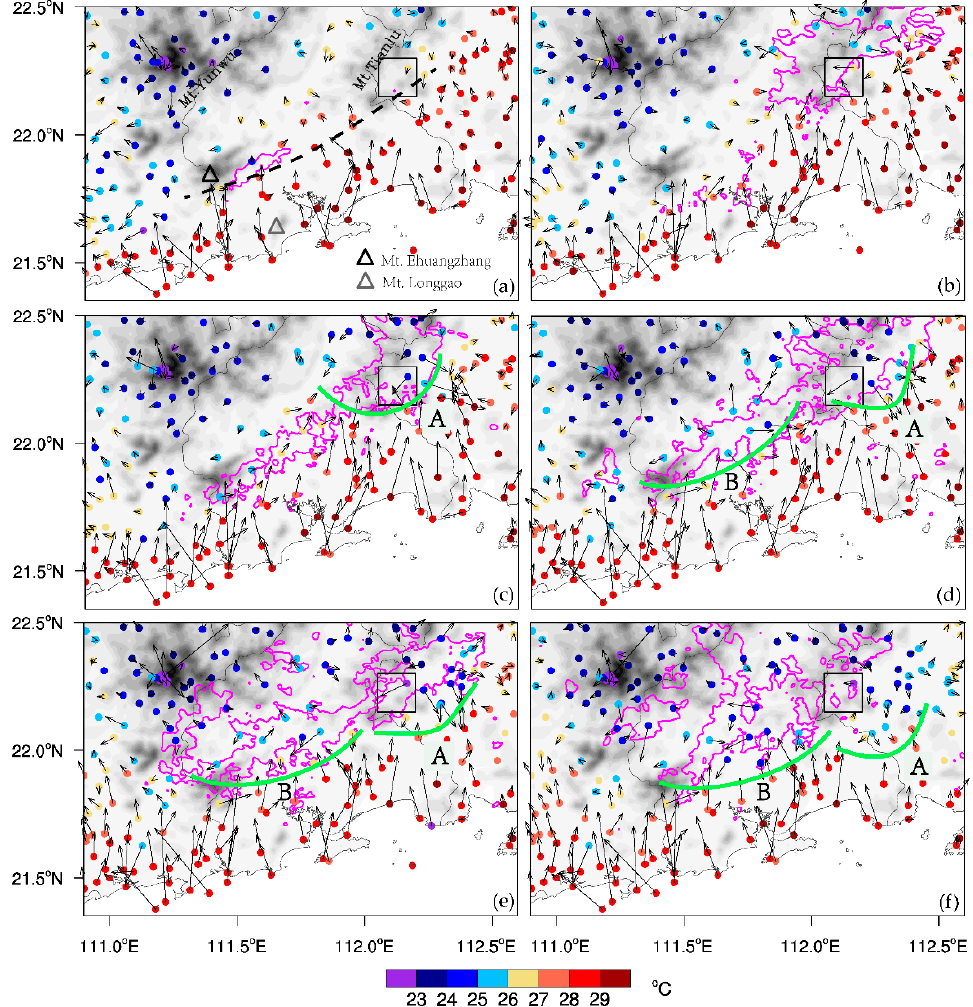
Figure 7. Surface air temperature (solid dot) and horizontal wind (arrow) at ( a ) 2100 LST 21, ( b ) 0100 LST 22, ( c ) 0200 LST 22, ( d ) 0300 LST 22, ( e ) 0400 LST 22 and ( f ) 0500 LST 22. Terrain is shaded in gray. The black dashed line in ( a ) represents the mesoscale convergence line related to the initiation of convection. Solid magenta contours represent the convective precipitation regions ( Z H of YJ S-POL at 1.5° elevation > 35 dBZ). Solid green lines denote the outflow boundaries based on contrasts in wind direction and temperature. The small black box represents the key region, as in Figure 1b.